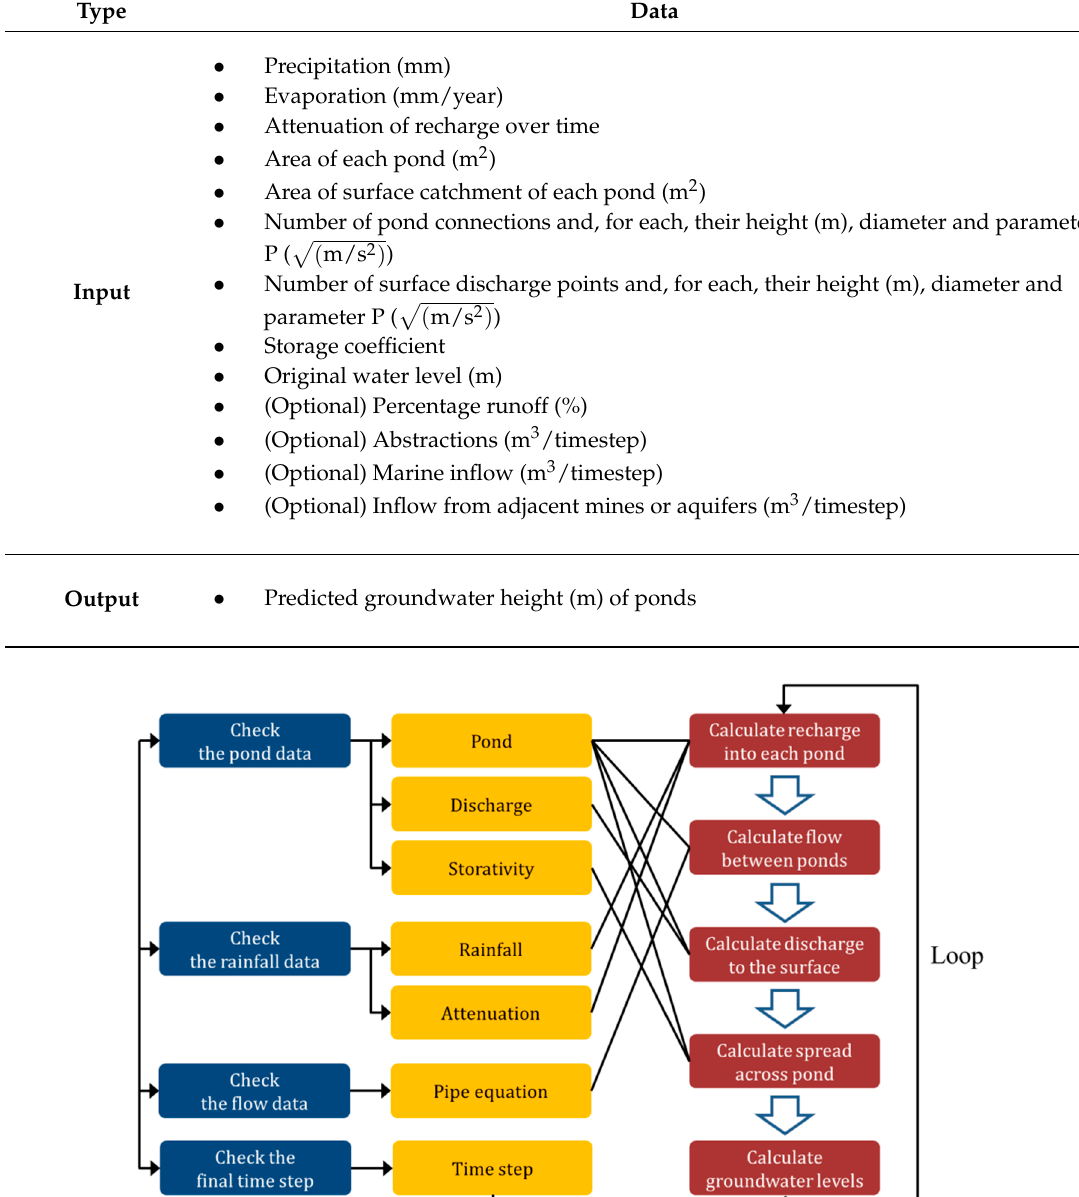
Table 1. SIMPL program input and output data.